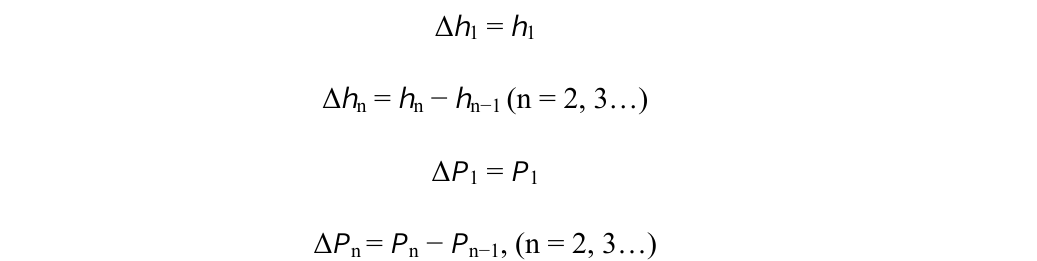
as a function of the penetration depth under different n